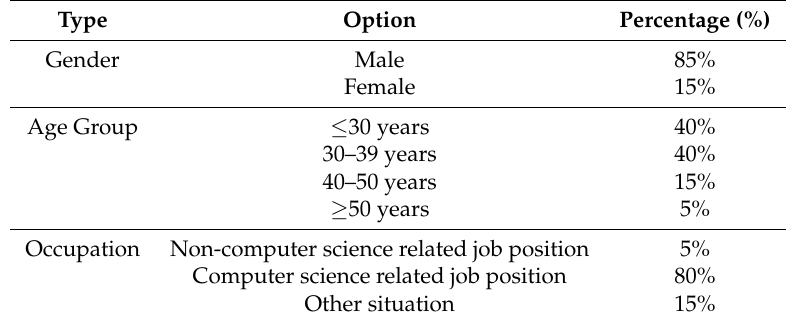
Table 1. Demographic